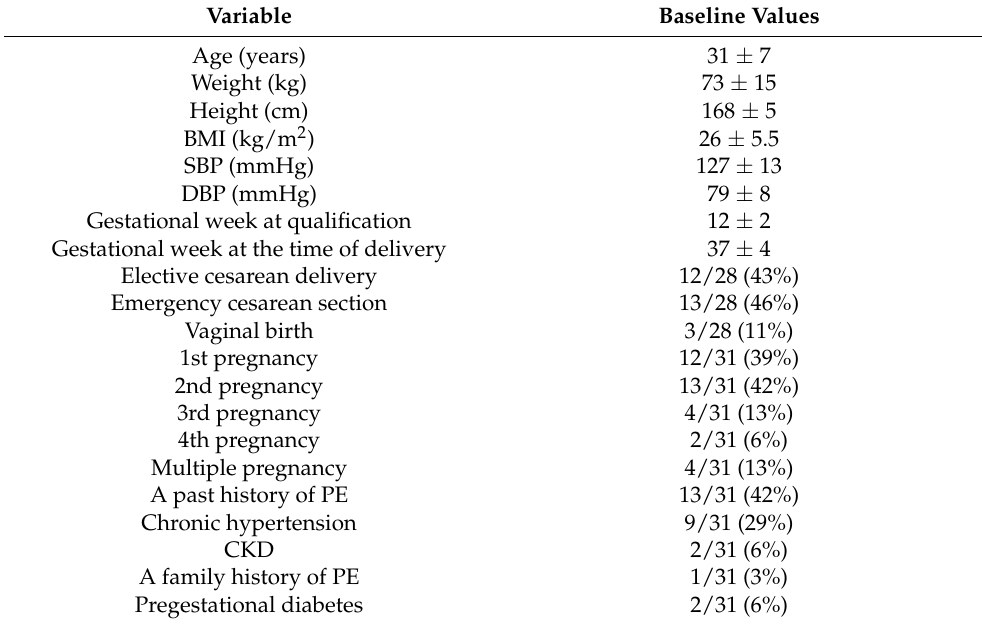
Table 1. Baseline characteristics. Abbreviations: BMI, body mass index; SBP, systolic blood pressure;